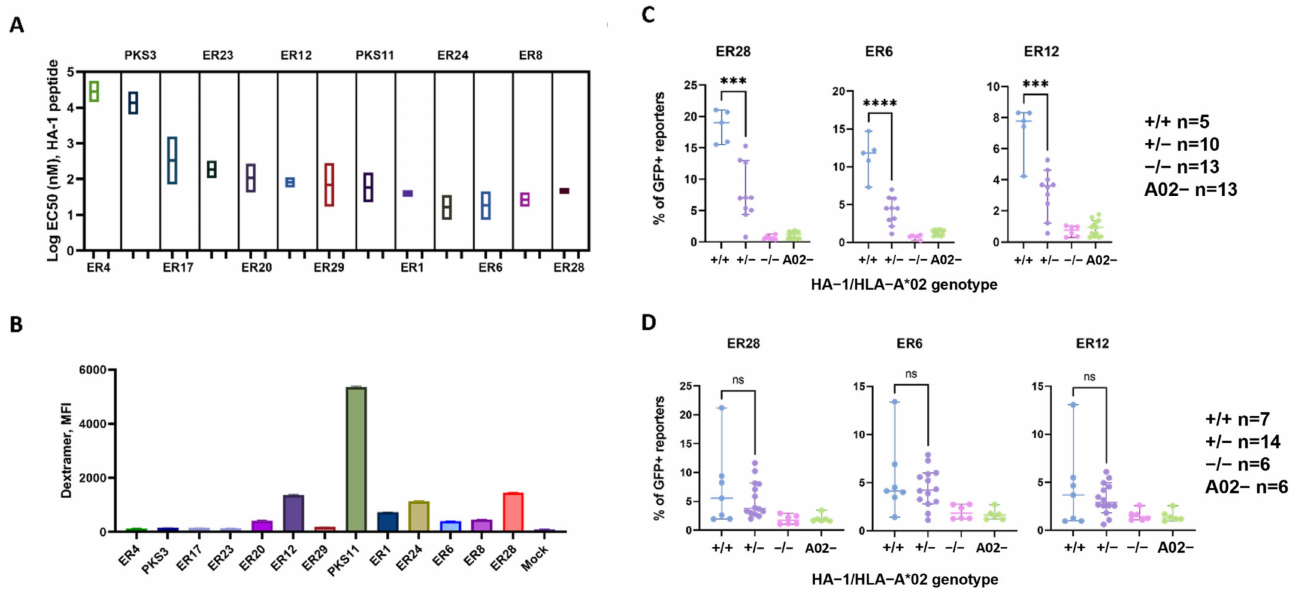
Figure 3. J76 cells modified with HA-1 − specific TCRs showed a response to the exogenously and endogenously processed HA-1 peptide and were stained with HA-1 HLA-A*02:01 dextramer. ( A ) J76 cell lines carrying functional HA-1 specific TCRs were stimulated by HLA-A*02:01 + K562 cells loaded with different concentrations of HA-1 peptide as described in Materials and methods. Mean values of log 10 (EC 50 ) for each TCR were obtained from two independent peptide titration experiments. ( B ) The J76 reporter cell lines staining with HA-1 HLA-A*02:01 dextramer. MFIs from three independent stainings are shown; error bars represent mean absolute error. ( C , D ) The J76 reporter cells expressing transgenic TCRs were stimulated by PBMC from healthy donors ( C ) and leukemia patients ( D ). Each dot represents the mean percentage of the GFP + reporter cells from three independent stimulation experiments using cells of a single donor with an indicated